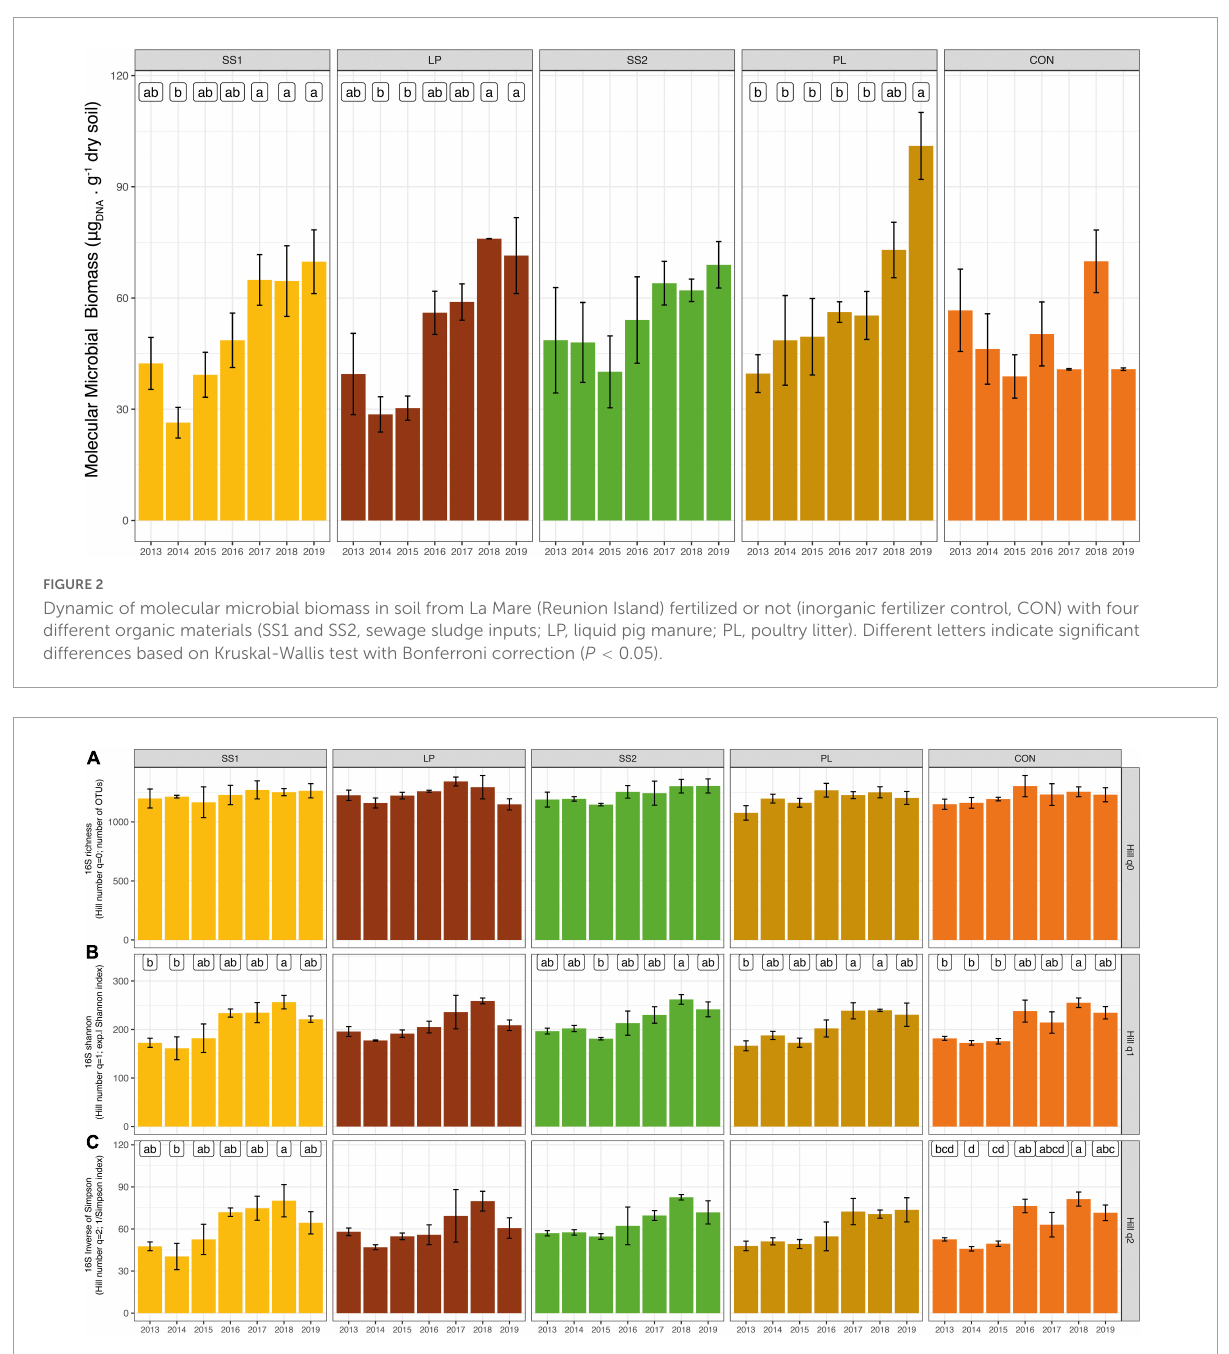
FIGURE3 Dynamic of the bacterial and archaeal community based on Hill numbers [Hill number with an order 0 (A) , 1 (B) , and 2 (C) ] in soil from La Mare (Reunion Island) fertilized or not (CON, inorganic fertilizer control) with four different organic materials (SS1 and SS2, sewage sludge inputs; LP, liquid pig manure; PL, poultry litter). For each treatment, different letters indicate significant differences between years based on Kruskal-Wallis test with Bonferroni correction ( P <